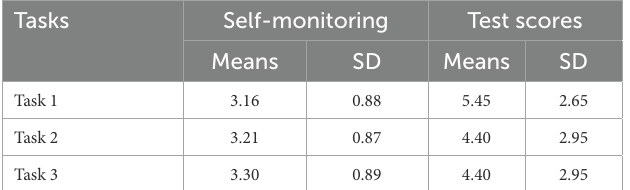
TABLE 1 Descriptive analysis of self-monitoring and test scores across